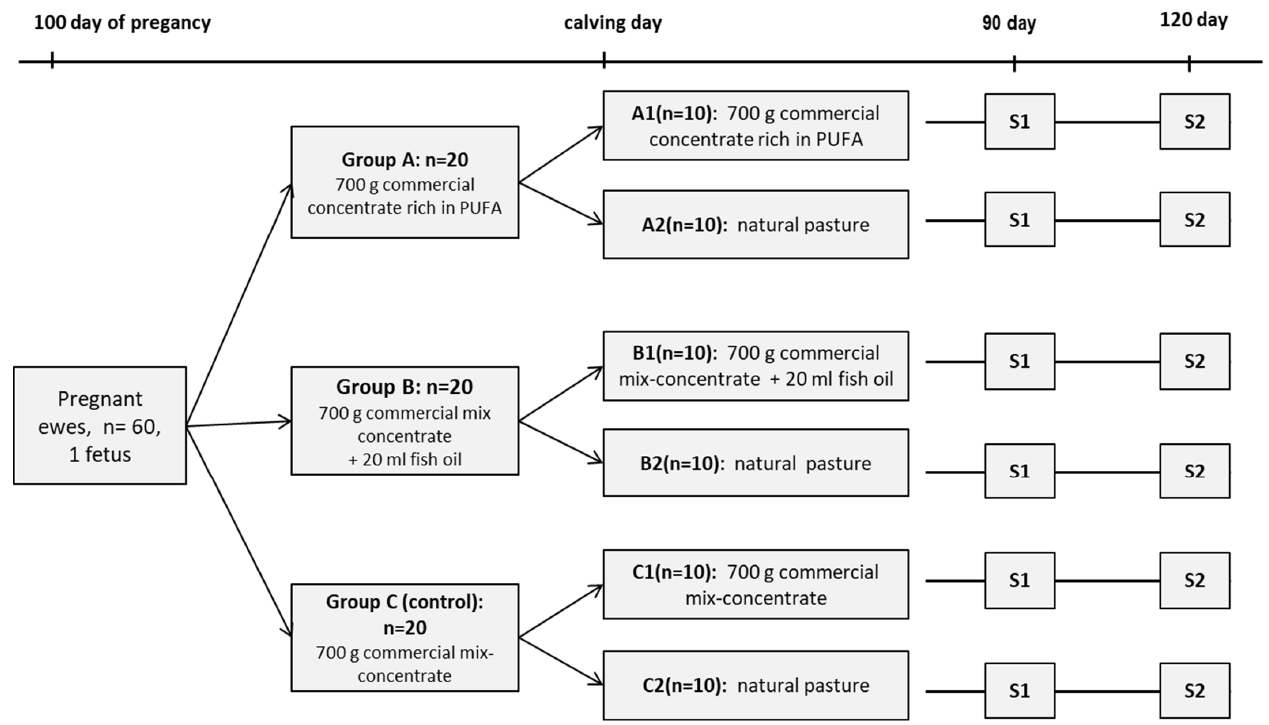
Figure 1. Experimental protocol. n-3 polyunsaturated fatty acids (n-3 PUFA). Group A: fed with 700 g of a diet rich in PUFA before birth; Group B: fed with 700 g of the commercial mix-concentrate together with 20 mL of Vita-Mega3 ® before birth; Group C: fed with 700 g of the commercial mix- concentrate; Group A1, B1 and C1: fed after birth the same as the prepartum; Group A2, B2 and C2: fed only on natural pasture during the same time period. S-1: sample 1 at 90 days; S-2: sample 2 at 120 days.